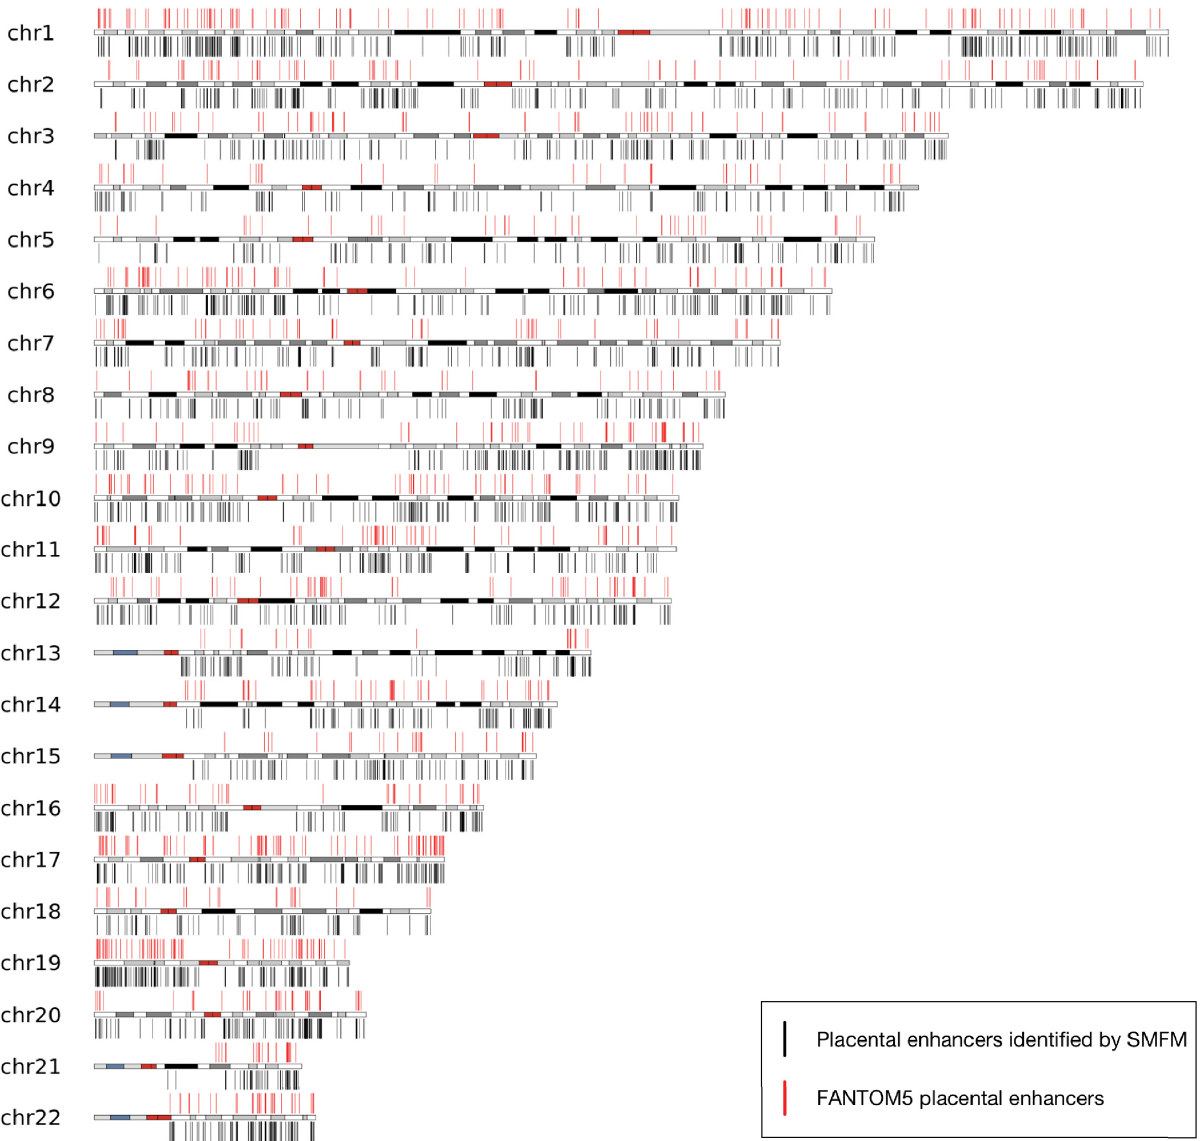
Fig 10. Visualization of placental enhancers identified by SMFM and FANTOM5 placental enhancers on hg19 autosomes, where red lines indicates placental enhancers from FANTOM5 atlas, the identified placental enhancers are shown using black lines. The red regions in autosomes are centromeres, and white regions and regions colored from gray to black represents Giemsa negative and positive regions, respectively. The highly variable and tightly constricted regions on the p-arms of 13, 14, 15, 21, 22 chromosomes that cannot be predicted are shown as blue and